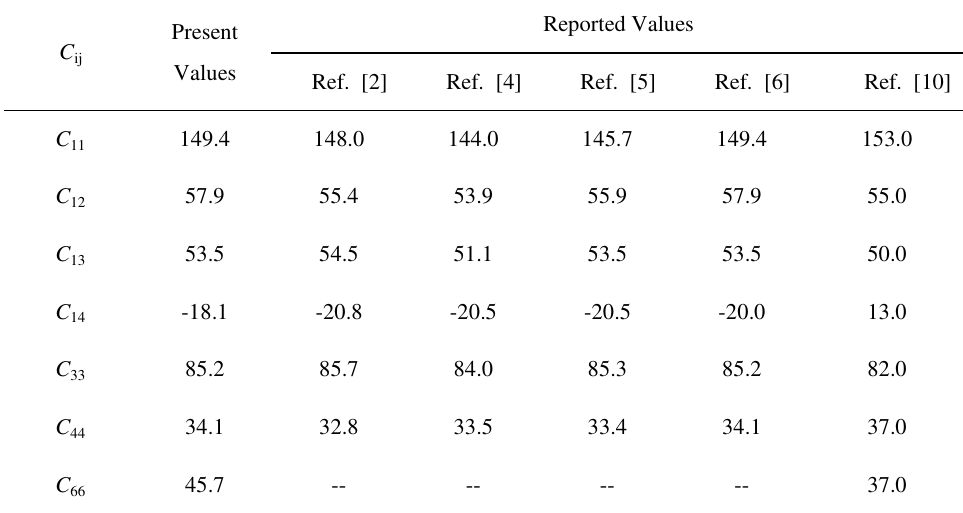
Table 2 Second-order elastic constants of Calcite (in G Pa) along with the reported values